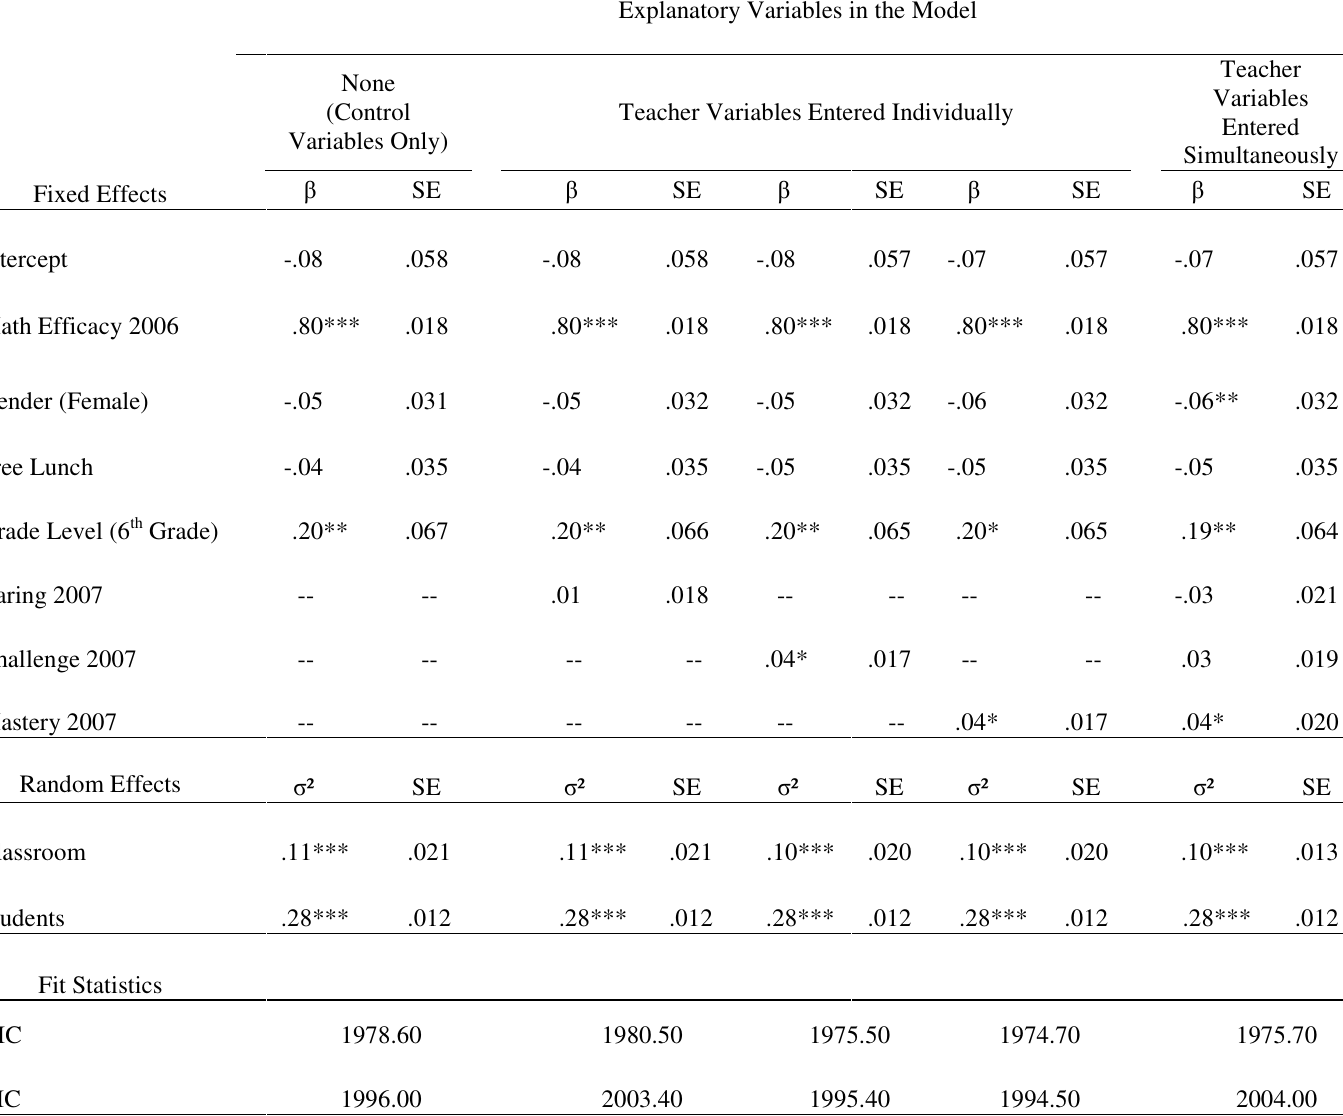
Math Performance 2007 Regressed on Teacher